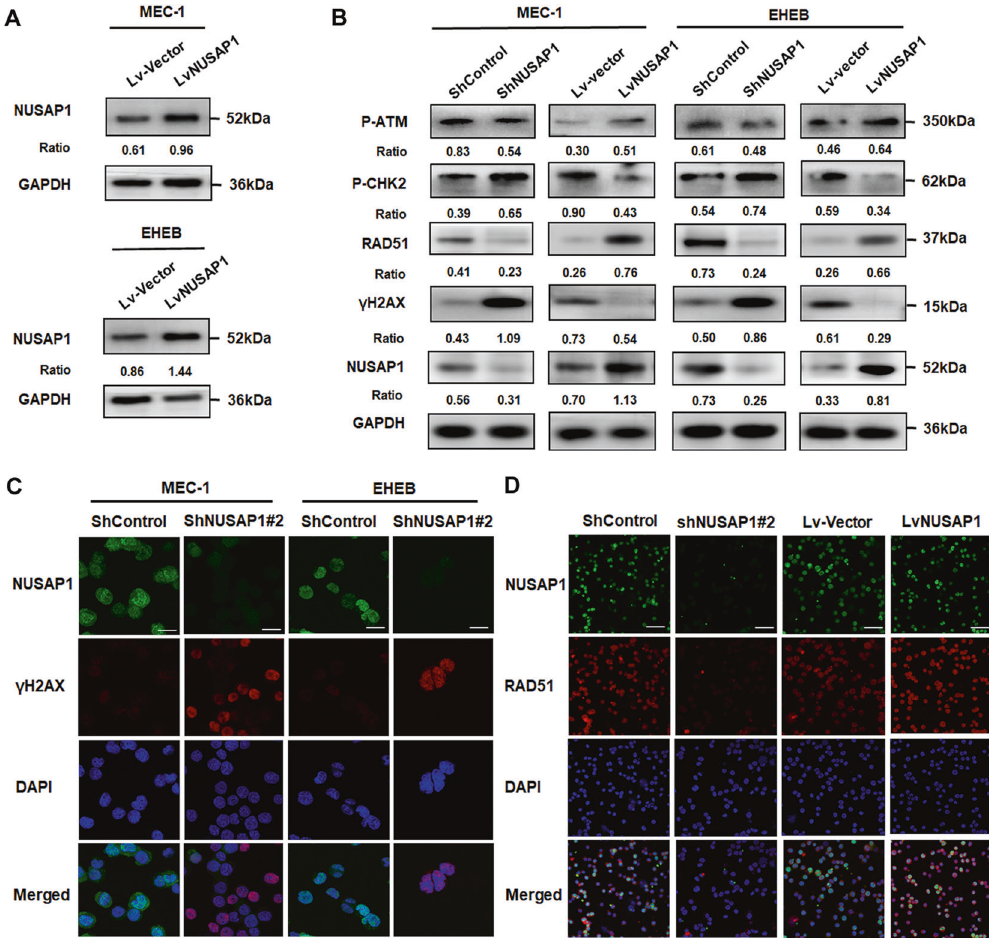
Fig. 4 DNA damage in CLL cells induced by suppression of NUSAP1. A Western blotting veri fi cation of CLL cells with NUSAP1 overexpression. B Protein expression of DDR in CLL cells with NUSAP1 decrement and overexpression by western blotting analysis. C IF staining of γ H2AX in CLL cells with NUSAP1-expression changed. Bar: 20 μ m. D IF staining of RAD51 in MEC-1 cells with NUSAP1-expression changed. Bar: 50 μ